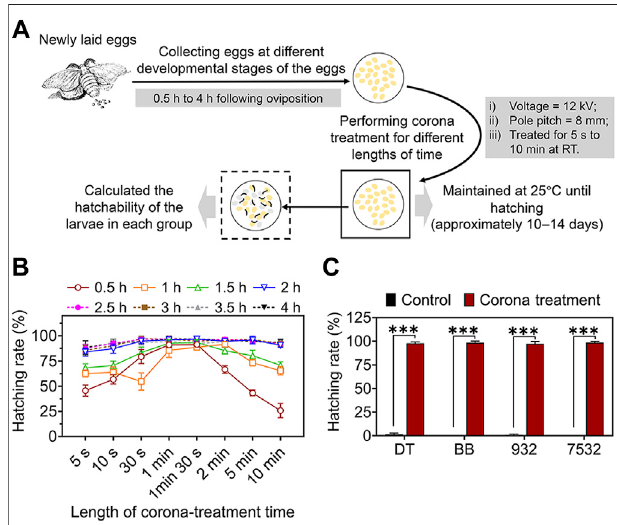
FIGURE 4 | VECT-mediated arti fi cial incubation of eggs within 4 h of oviposition. (A) Schematic diagram of the experimental process of treating newly laid eggs within 4 h of oviposition by VECT. (B) Line charts of the larval hatching rates of the DZ eggs treated with a combination of different conditions within 4 h of oviposition. Error bars represent one standard deviation( n =3). (C) Thelarvalhatchingratesofthenewlylaideggsfromother commercial parental strains following corona treatment for 1 min at 2 h after oviposition. The eggs of each strain that were not subjected to any treatment were considered the control. Error bars represent one standard deviation ( n = 3; n.s., not signi fi cant; *** p <